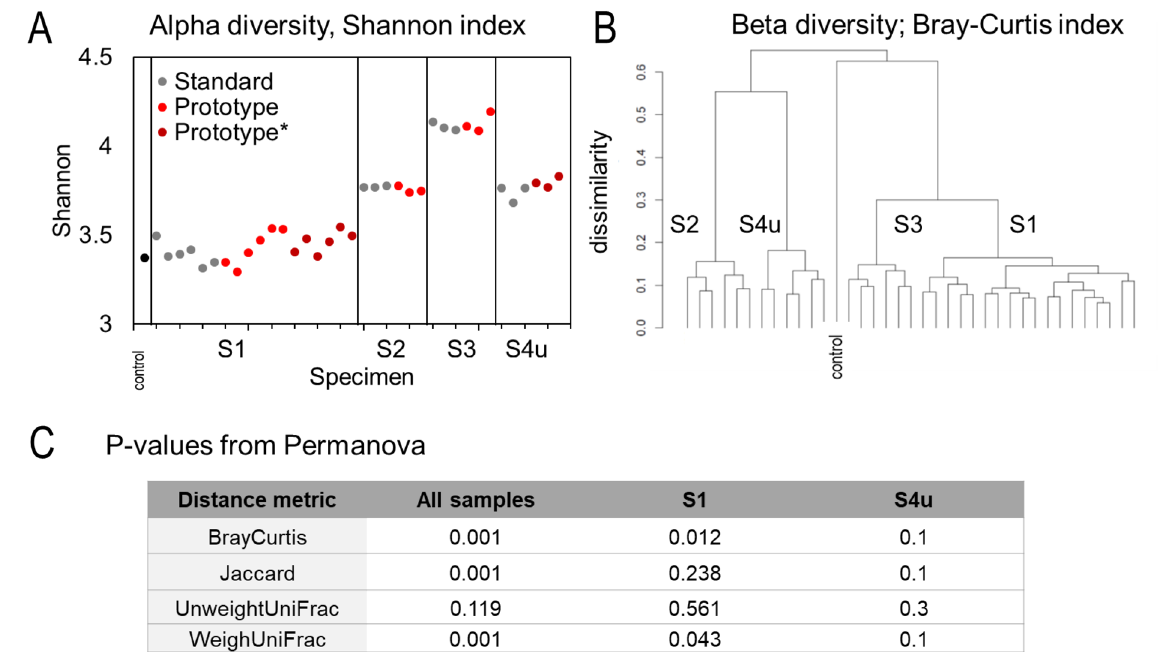
Figure 5. Microbiome analysis result of n = 36 fecal specimens from stool S1, S2, S3, and s4u. ( A ) Within- sample microbial species diversity (Alpha diversity, Shannon index) by stool and by sampling approach. * denotes sample centrifuged prior to nucleic acid extraction. ( B ) Hierarchical clustering using beta diversity index showing taxonomical distance: the clustering is around the stools not around the sampling approach. ( C ) P-value from permanova analysis of beta diversity metric comparing sampling methods (standard vs prototype) for test groups of interest: all stool samples (controlling for stools), stool 1 and stool 4u. P < 0.05 is statistically